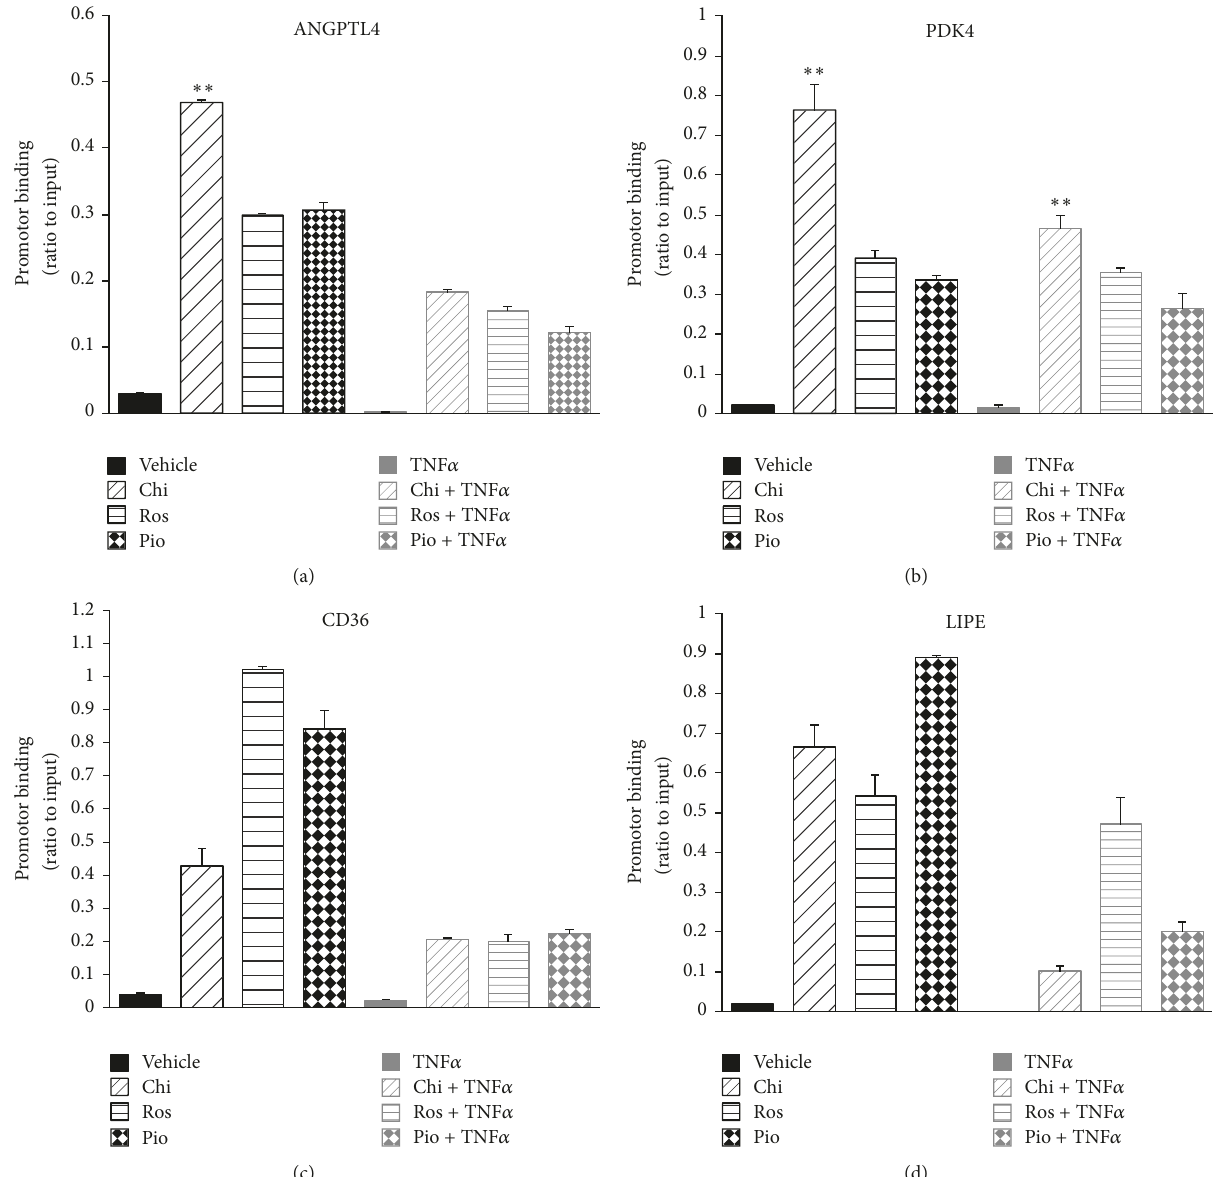
Figure 6: Chiglitazar differentially affects promoter binding of PPAR 𝛾 -containing transcription complexes. HPA-v cells were incubated with Chi (1 𝜇 M), Ros (1 𝜇 M), Pio (1 𝜇 M), and vehicle control (0.1% (vol/vol) DMSO) in the presence or absence of TNF 𝛼 (5ng/ml) for 24 hours. ChIP assays using anti-PPAR 𝛾 antibody were then performed as described in Materials and Methods . The relative abundance of promoters bound to PPAR 𝛾 was normalized against the input control sample. The diagrammed results represent the average of two independent experiments. ∗∗ represents statistically significant differences in promoter binding induced by chiglitazar compared to the other two TZDs ( 𝑝 < 0.01